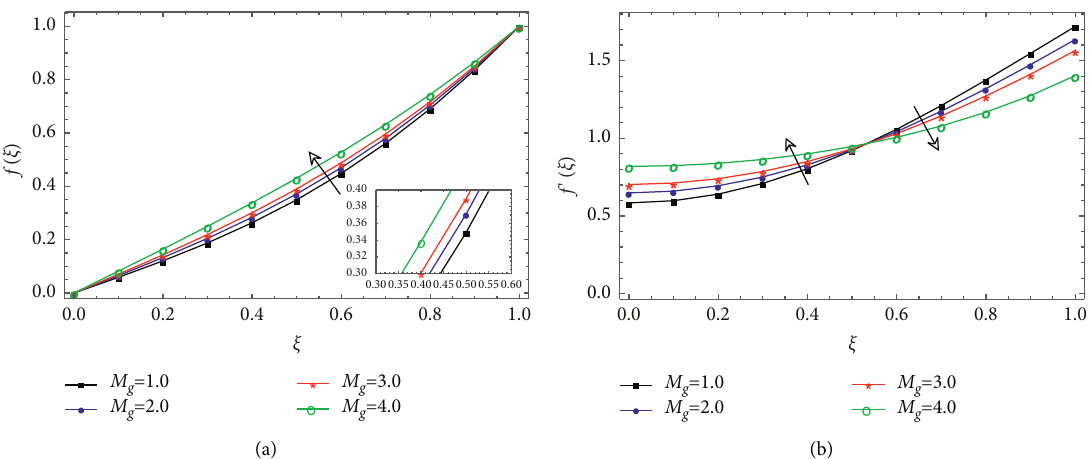
Figure 9: Effect of M g on the velocity profile keeping (b) Axial component of